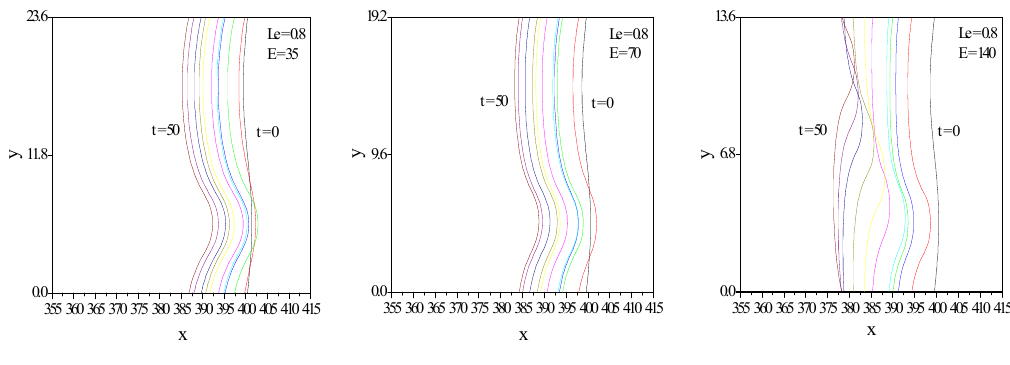
Fig. 7. The evolution of cellular fronts at Le = 0.8 and E = 35, 70 and 140 in adiabatic flames ( t = 0, 5, 10, . . . , 50).